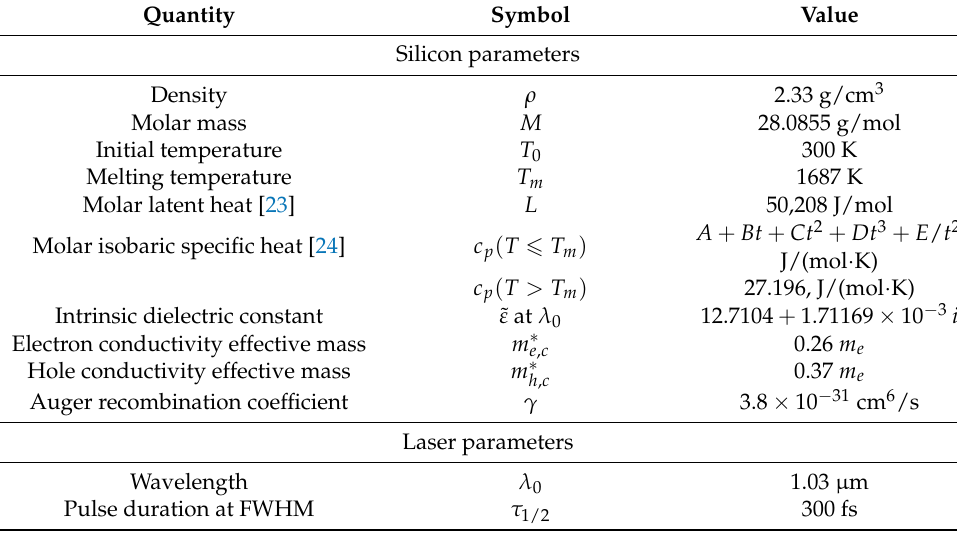
Table 2. Modeling parameters. The coefficients for the isobaric specific heat equation are A = 22.81719, B = 3.89951, C = − 0.082885, D = 0.042111, E = − 0.35406, and t = T /1000, T in